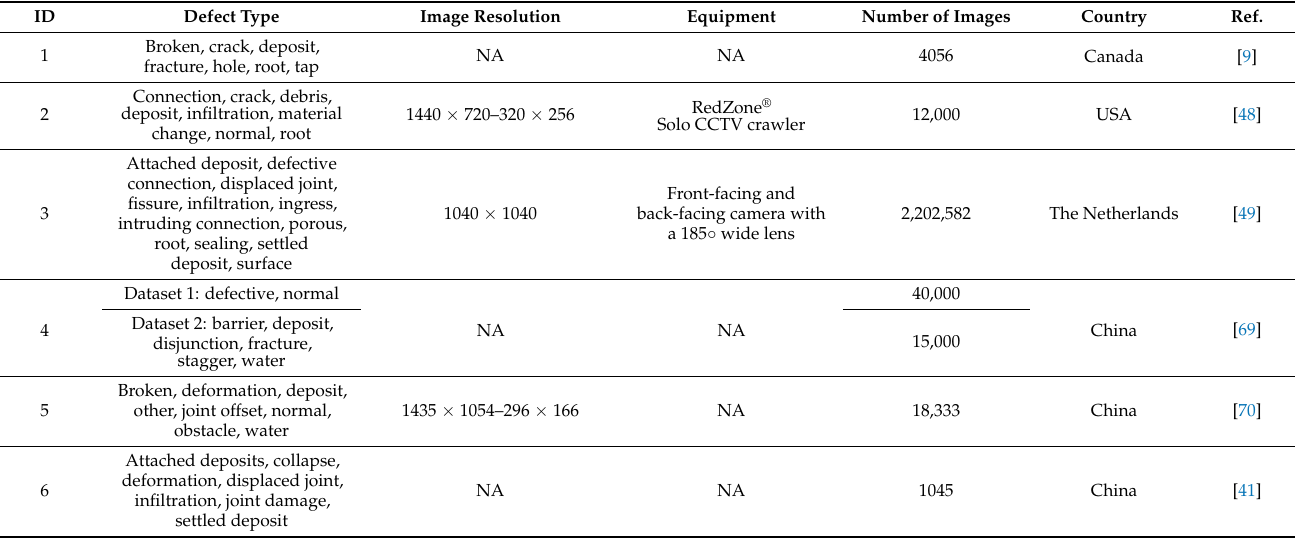
Figure 13. Sample images from the Sewer-ML dataset that has a wide diversity of materials and shapes. Table 6. Research datasets for sewer defects in recent studies.